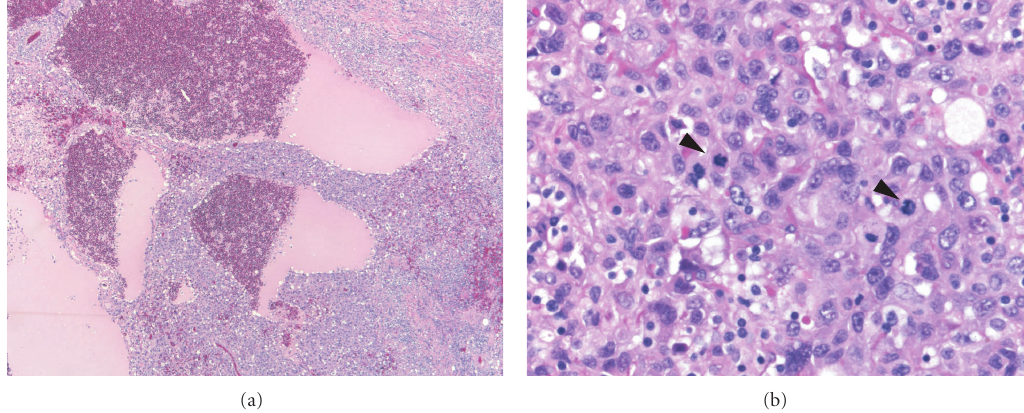
Figure 3: Representative light photomicrographs from the epithelioid areas of the excision. (a) Low power showing large irregular vascular spaces and sheets of epithelioid cells. (b) Close-up view showing large epithelioid cells with moderately abundant cytoplasm, vesicular nuclear chromatin with prominent nucleoli, occasional intracytoplasmic RBC containing lumina, and a high mitotic rate (Arrows).